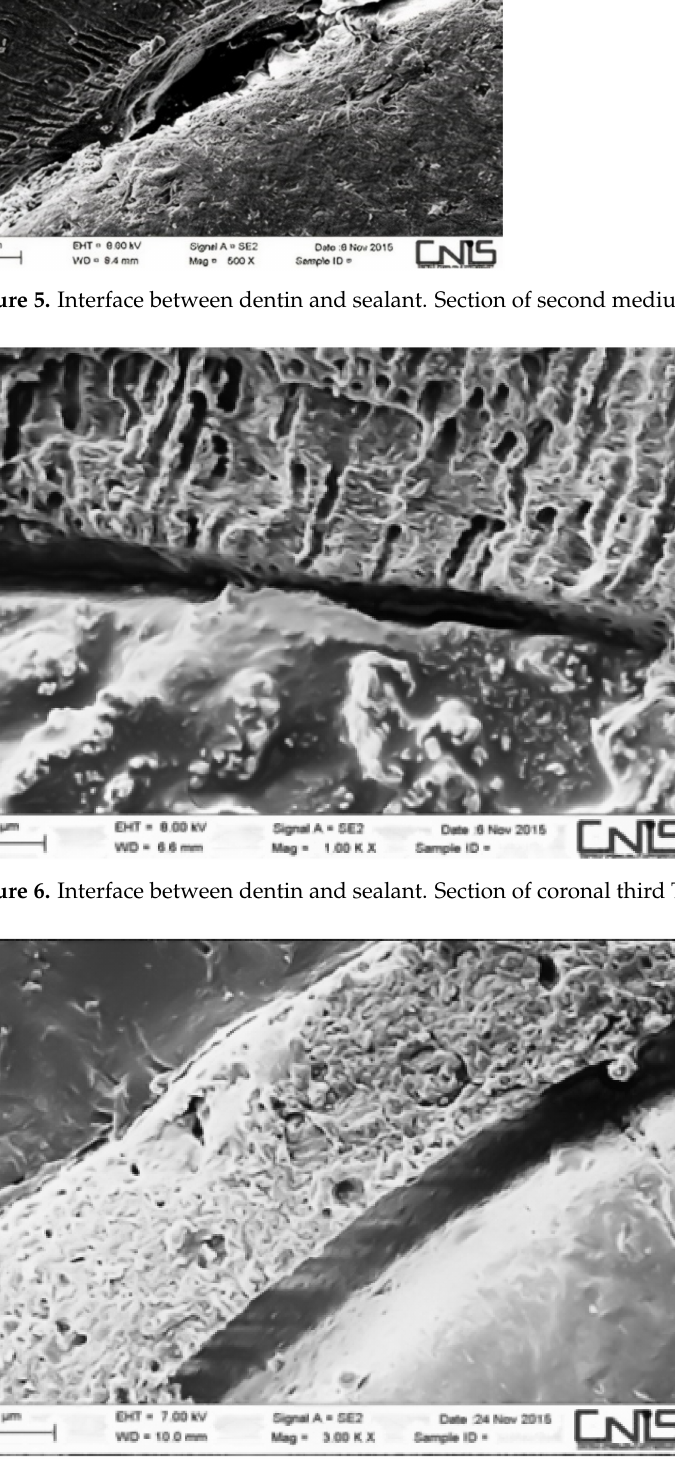
Figure 7. Interface between dentin and sealant. Section of apical third G